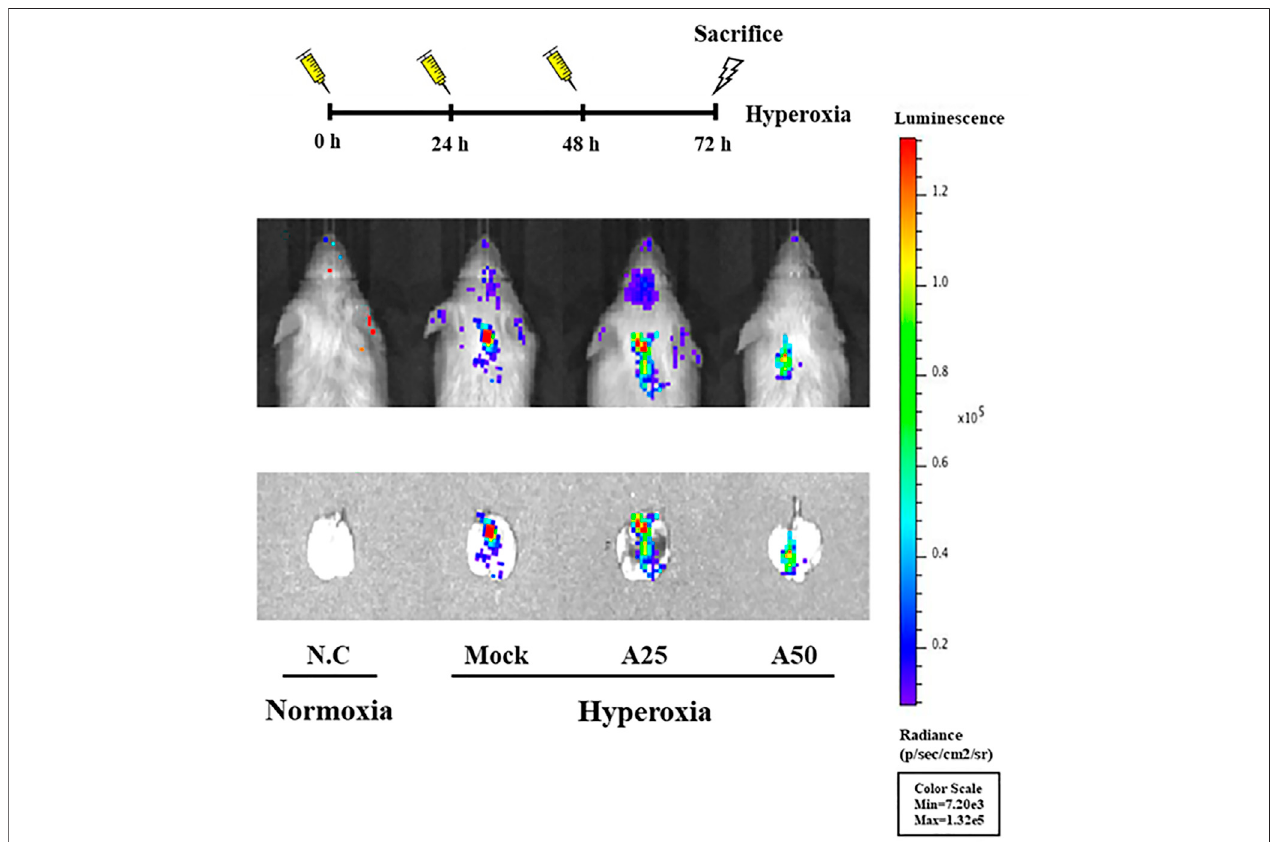
FIGURE1| Bioluminescence imagingindicating thetherapeuticef fi cacyofaspirin inthelungtissues ofNF- κ B-luciferase +/+ transgenic mice exposedtohyperoxia. NF- κ B-luciferase +/+ transgenic mice were assigned to four groups ( n (cid:1) 6 mice per group): N.C, treatment with PBS at 0, 24, and 48 h and exposureto normoxia; Mock, treatmentwith PBSat0,24,and 48 h and exposure to72 h ofhyperoxia;A25, treatment with25 μ g/gaspirinat 0, 24,and 48 h andexposureto72 hofhyperoxia;and A50, treatment with 50 μ g/g aspirin at 0, 24, and 48 h and exposure to 72 h of hyperoxia.